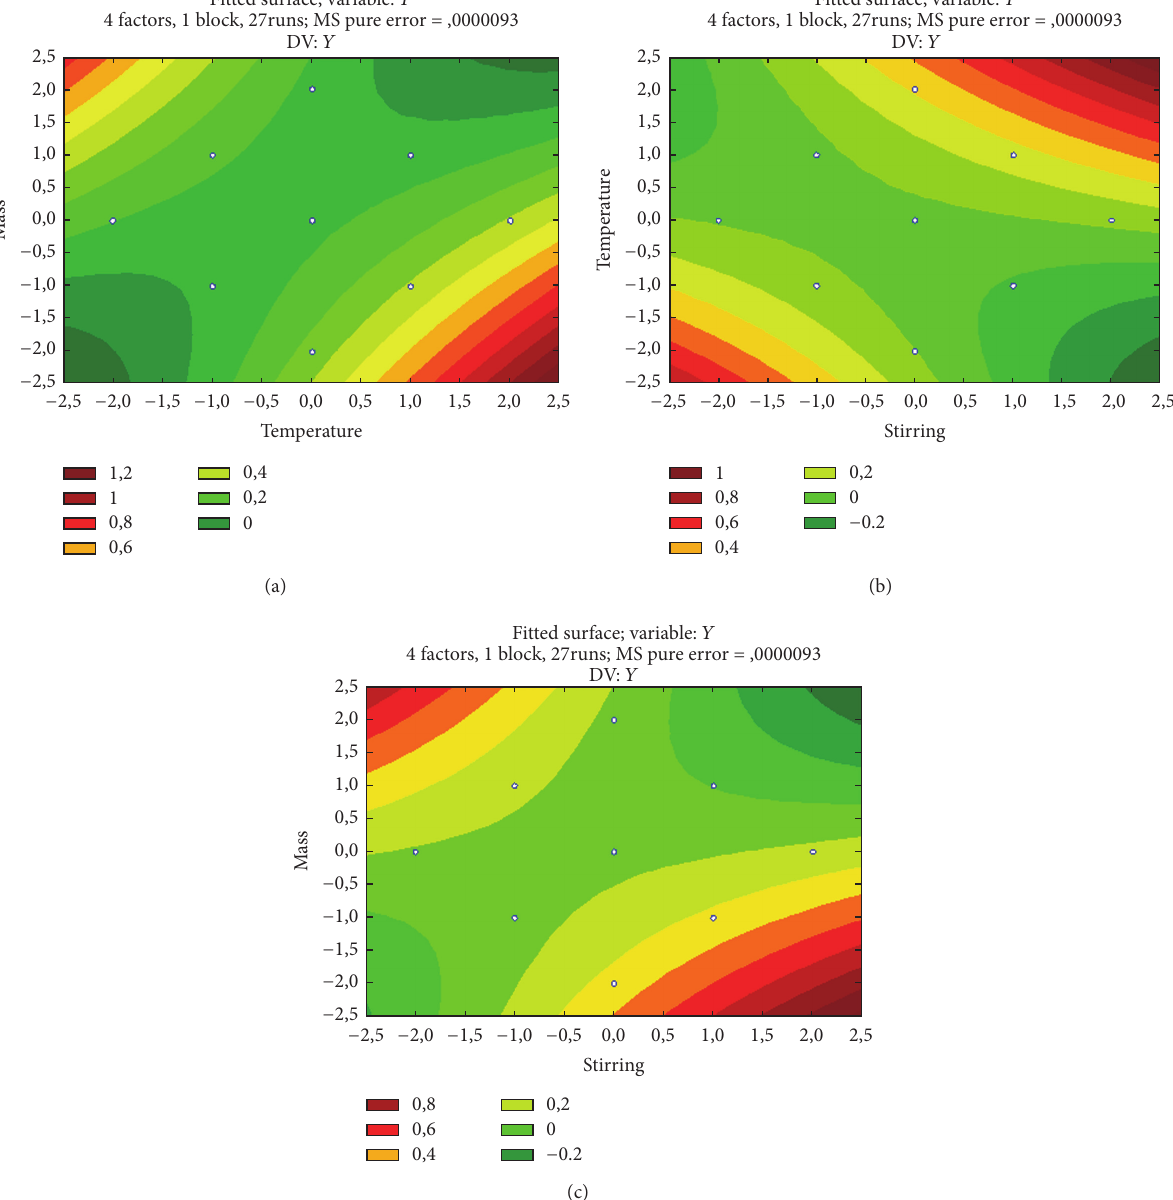
where 𝑌 is the percentage yield extraction and 𝑇 , 𝑆 , St, and 𝑚 are the uncoded values of temperature, solvent ratio, stirring, and solid : solvent ratio,